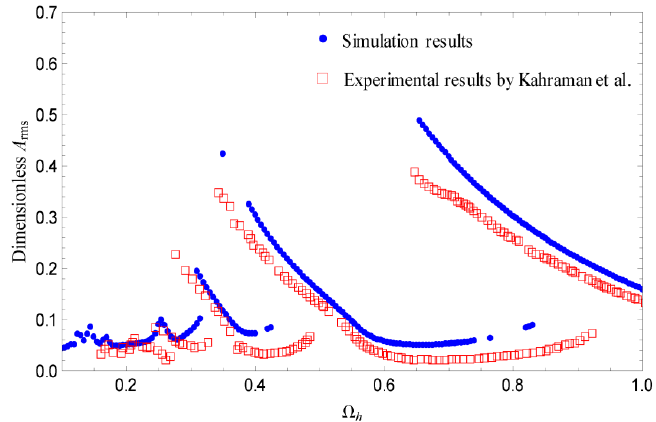
Figure 3. Simulation and experimental results of dimensionless 𝐴 𝑟𝑚𝑠 with frequency 𝛺 ℎ .